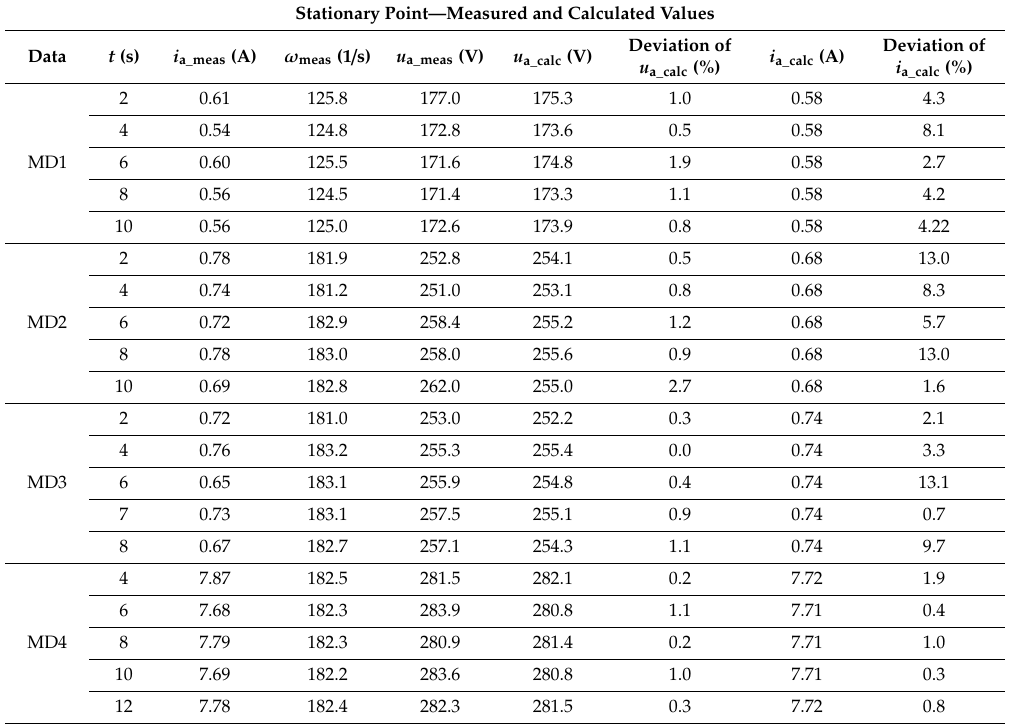
Table 18. Calculated current and speed using (25) and (26) and their deviation at selected points for MD1, MD2, MD3, and MD4 for calculated parameters obtained with RK.